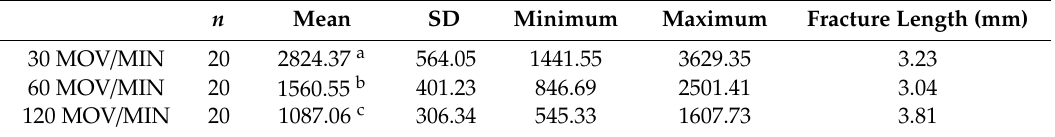
Table 2. Descriptive statistics of the NCF.